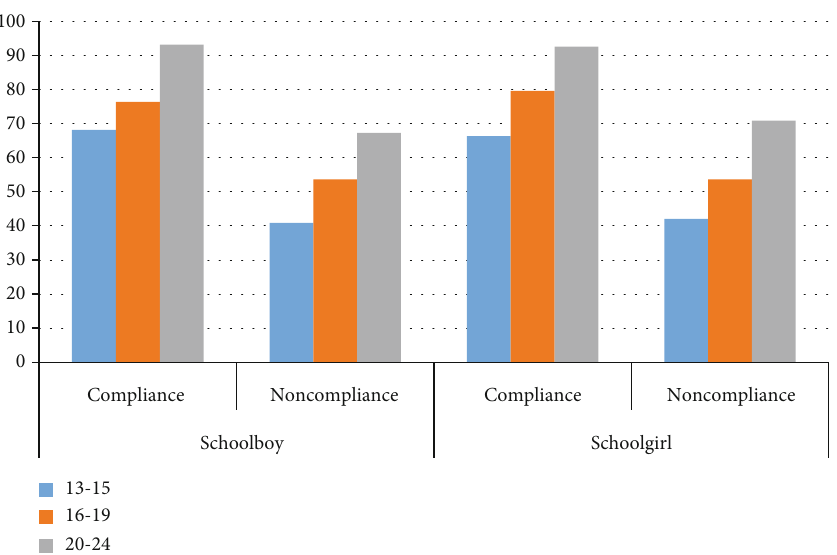
Figure 5: (Compliance/noncompliance) physical education achievement standard rate of students of di ff erent ages.